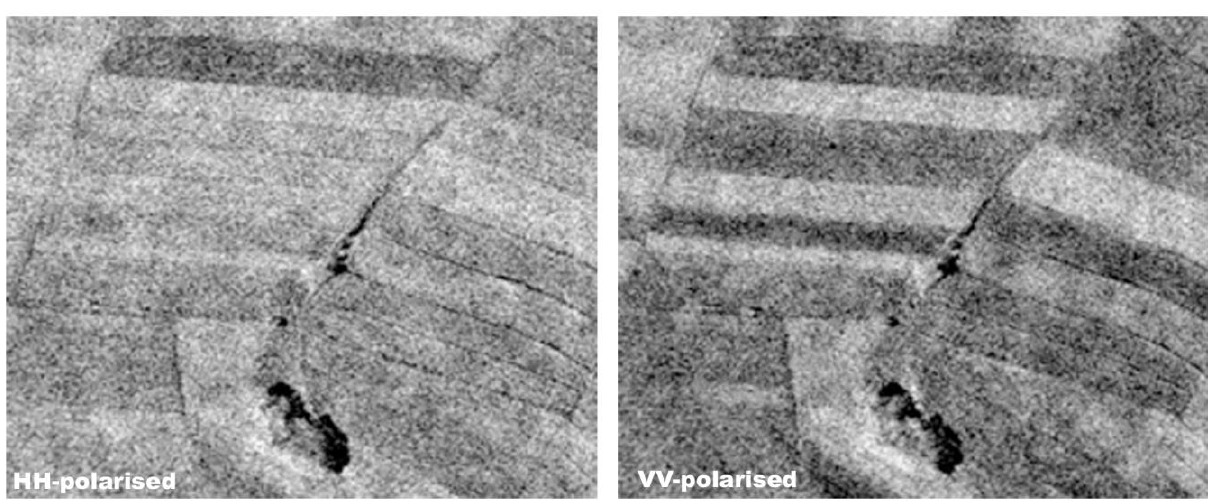
Figure 1. TerraSAR-X High Resolution Spotlight Image in HH and VV polarization. (© German Aerospace Center (DLR)